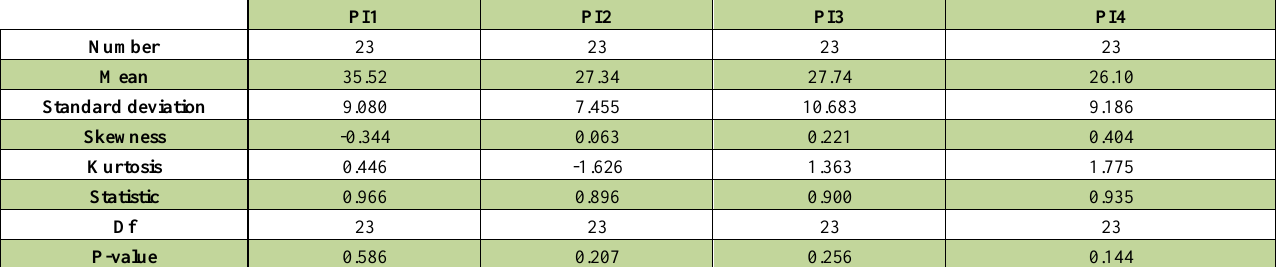
Table1. Determining the Normal Distribution of Study Data in Group I.